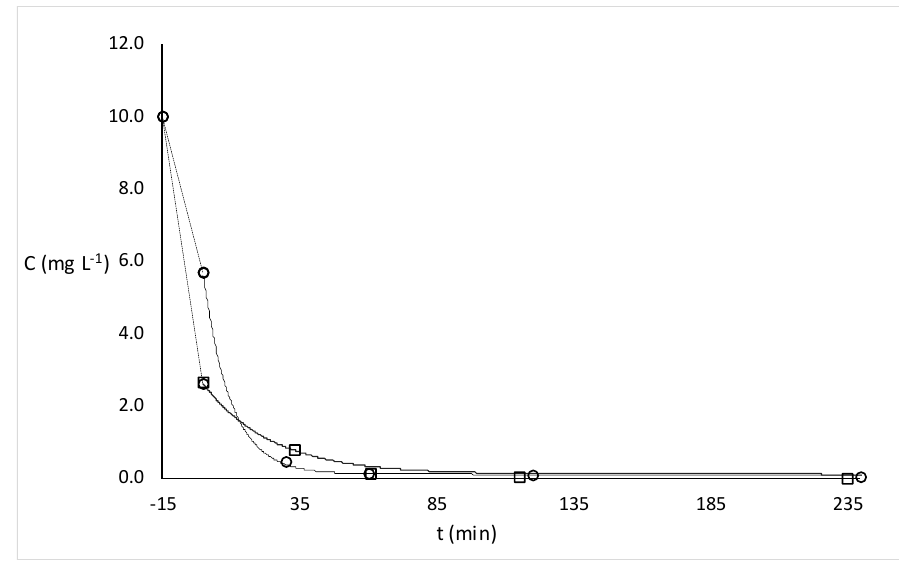
Figure 11. Degradation profiles of enrofloxacin (ENR) (10 mg L − 1 , tap water) solution obtained under simulated solar light in presence of 500 mg L − 1 p-C / TiO 2 (empty square) and Evonik P25 (empty circle).